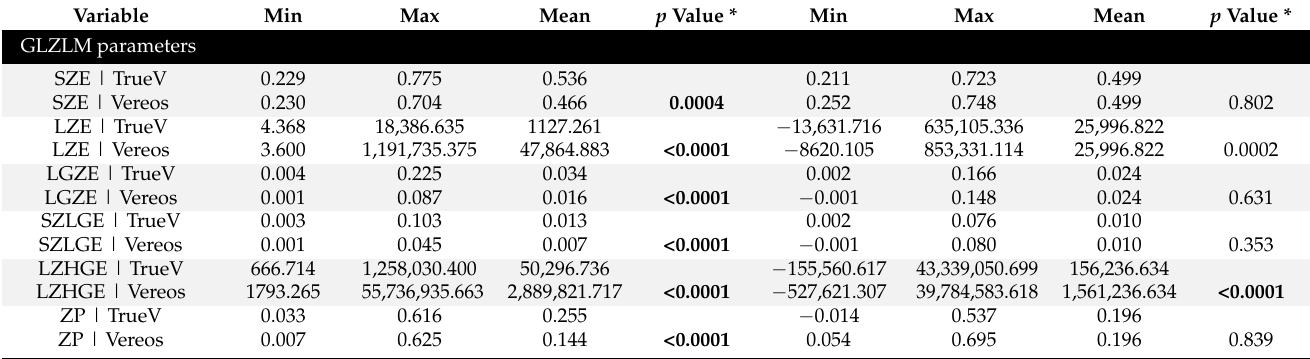
Figure 2. Coefficients ( a ) and cross-validation ( b ) plots of the LASSO analysis.